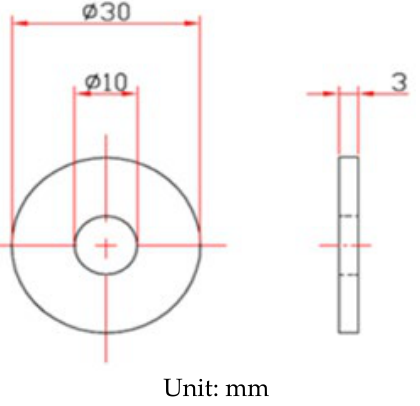
Figure 1. Dimensions of the specimen used for crevice corrosion test. Table 1. Chemical composition of the 304L stainless steel used in this study. Table 1. Chemical composition of the 304L stainless steel used in this study. Element